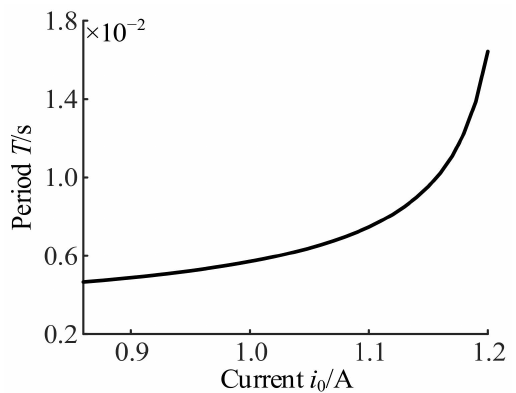
Figure 4. Curve of period T and current i 0